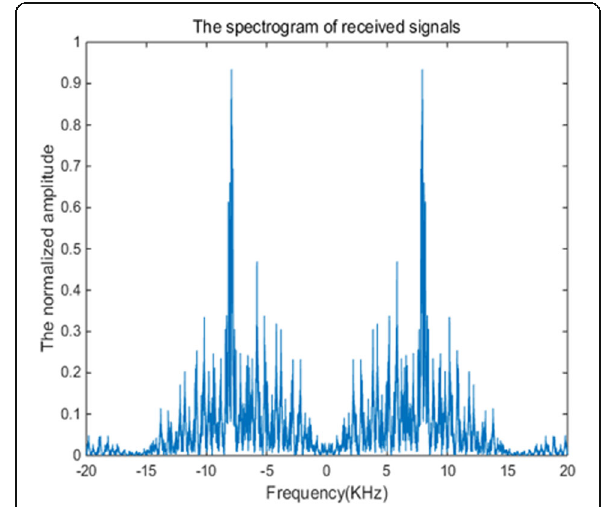
Fig. 7 The spectrogram of received signals when the SNR is 5 dB